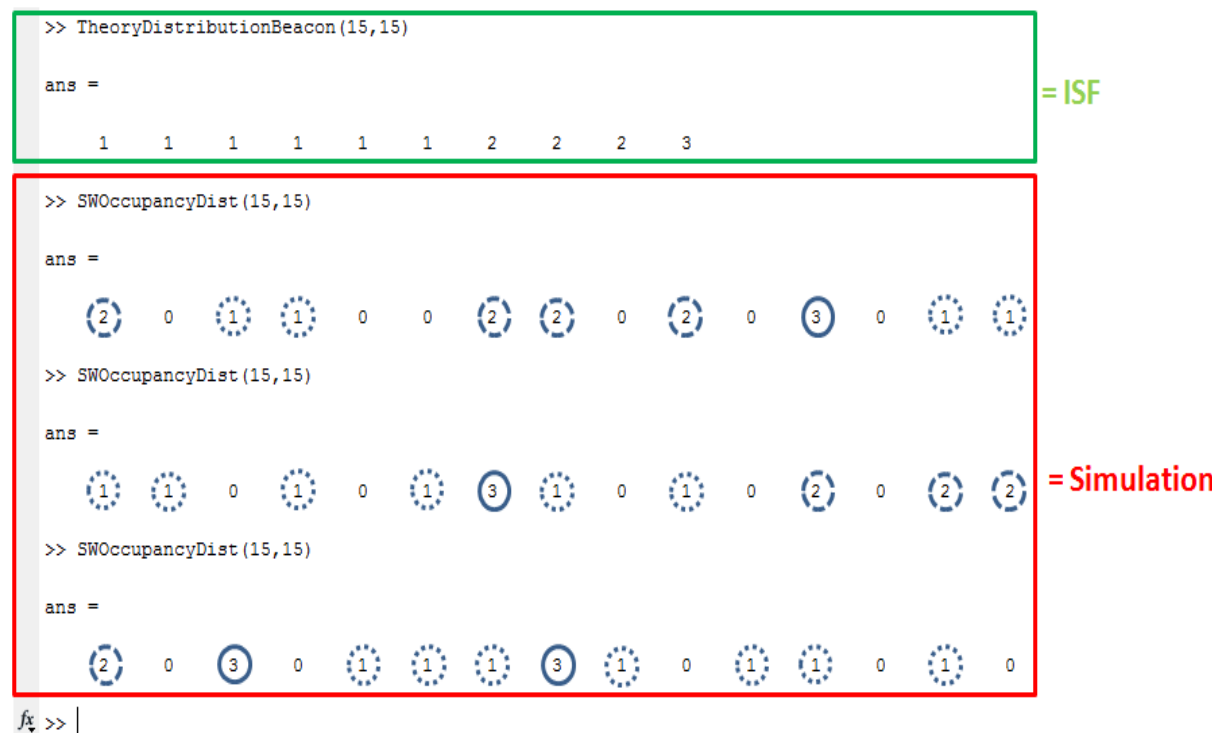
Figure 11. Comparison between the theoretical distribution of beacons using the ISF function and the simulated distribution, where (NB, SW)=(15,15).